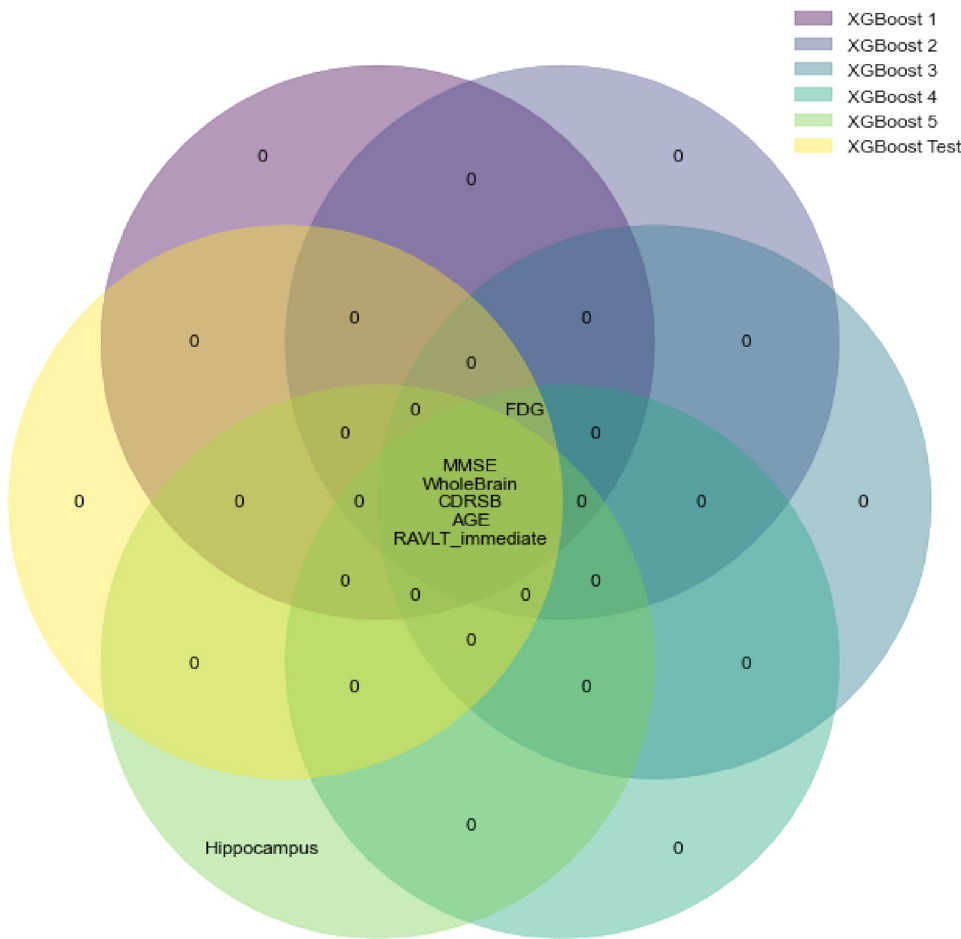
Figure 11. Venn diagram presenting features impact ranking for various XGBoost models based on 5-fold